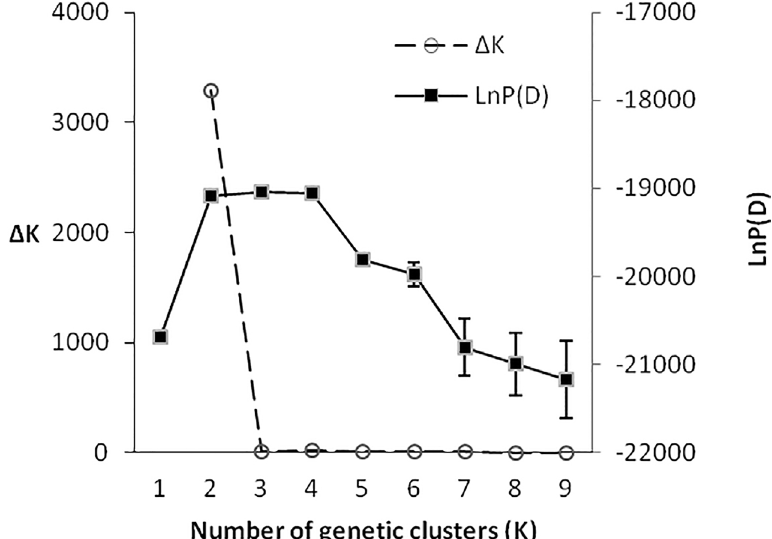
Figure 2. The rate of change in log-likelihood values (ΔK) and the mean (± standard deviation) ln likelihood (LnP(D)) based on the estimated number of genetic clusters (K) among caribou. The largest ΔK value represents the most probable number of genetic clusters, calculated as ΔK = m | L’’ ( K )|/ s [ L ( K )]. Values for K = 1 are invalid (Evanno et al.,